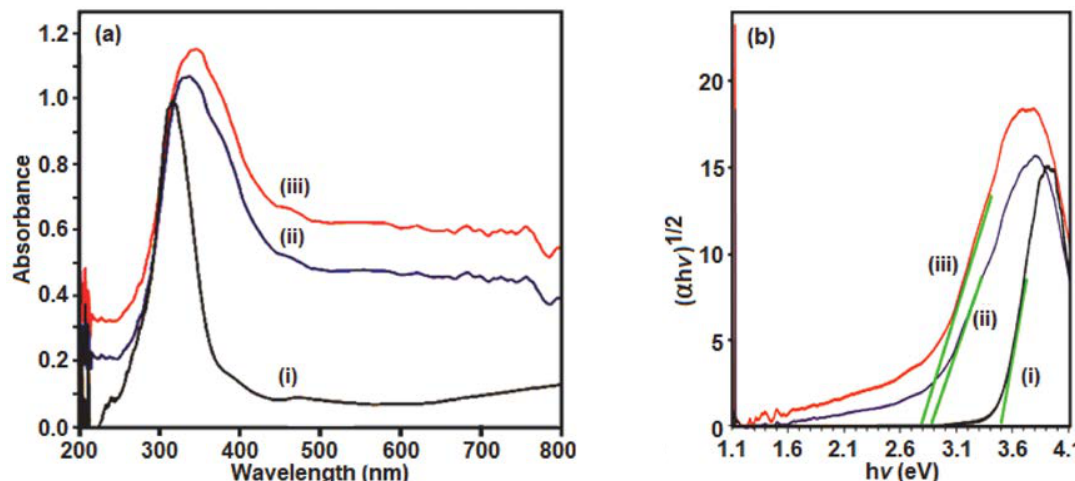
Figure 7. (a) UV-vis diffuse reflectance spectra and (b) (αh v ) 2 versus h v curves of (i) pure Bi 2 O 2 CO 3 (ii) Bi 2 O 2 CO 3 /CoFe 2 O 4 30% and (iii) CoFe 2 O 4